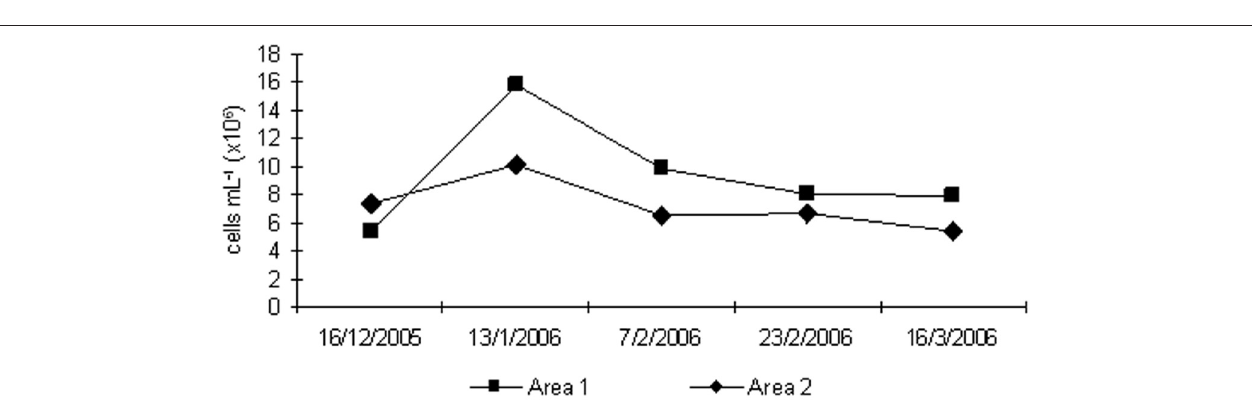
FIGURE 3 | Carbon dioxide productions in the Area 1 and in the Area 2 throughoutthe rice crop cycle ( n = 3).